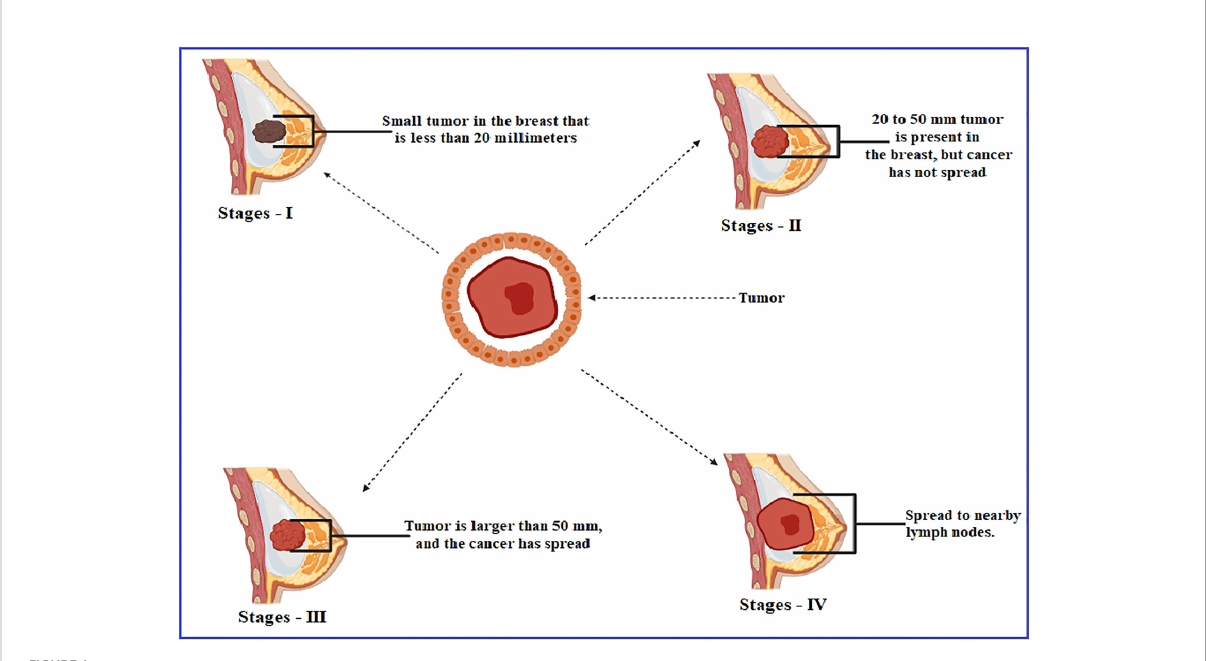
FIGURE 1 Development stages of breast